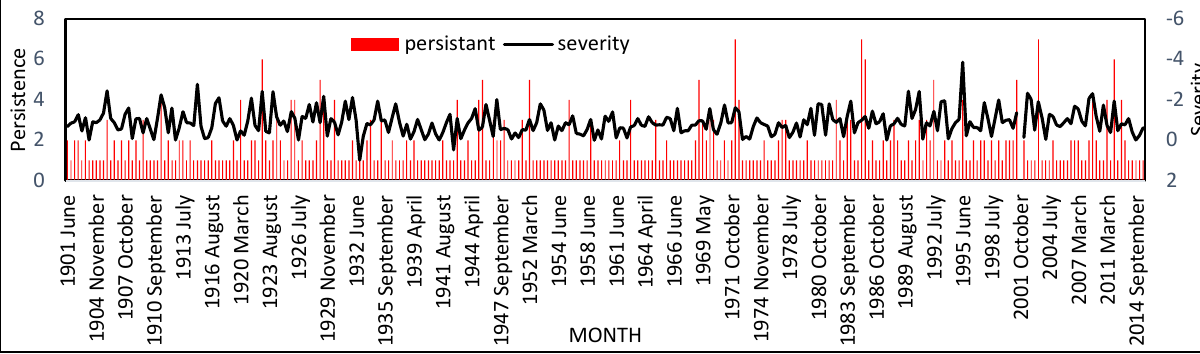
Figure 7.Persistence Severity Graph for the grid 166 (18.83N,76.108)